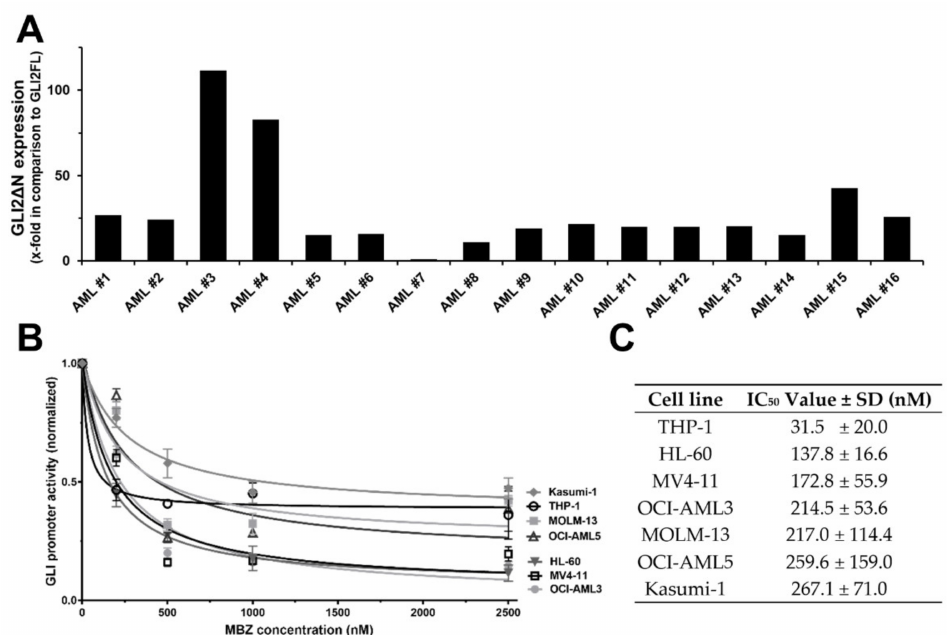
Figure 1. MBZ inhibits SMO independent non-canonical GLI signaling predominant in AML. ( A ) Pre- treatment samples of 16 different AML patients with detectable GLI2 expression were analyzed for GLI2FL and GLI2 ∆ N expression using RT-qPCR. GLI2 ∆ N expression was normalized to GLI2FL expression. ( B ) The AML reporter cell lines MV4-11, MOLM-13, HL60, THP-, Kasumi-1, OCI-AML3 and OCI-AML5 were treated with increasing MBZ concentrations or DMSO as solvent control. The GLI promoter activity was measured after 48 h. ( C ) The IC50 of MBZ on the GLI promoter activity of the different GLI reporter cell lines was calculated from the data shown in ( B ) using a nonlinear regression (curve fit) for inhibitor vs. response with three parameters in GraphPad Prism